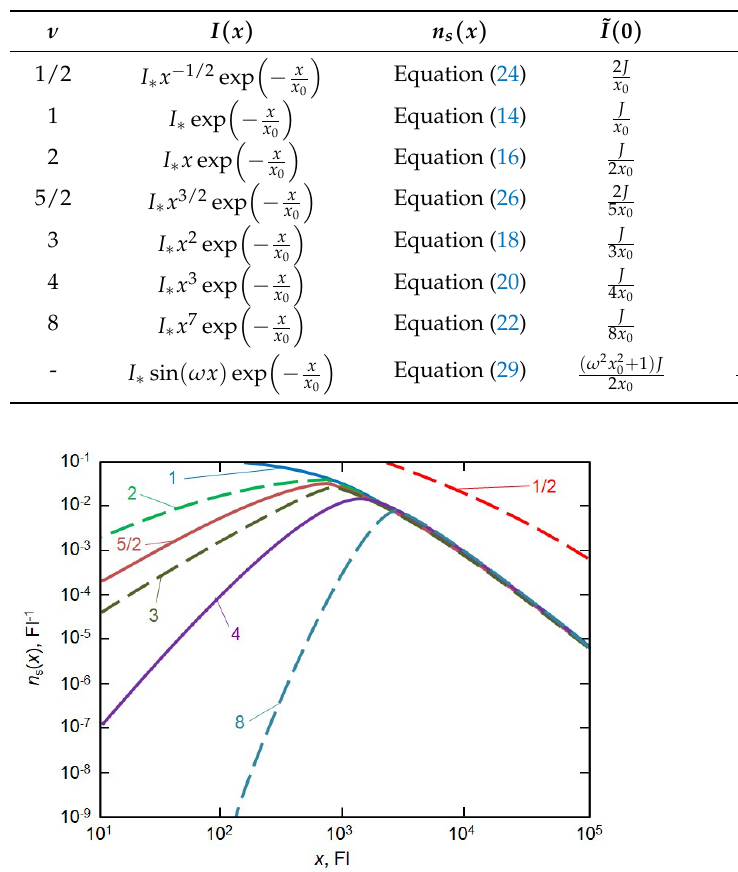
Table 1. A short summary of exact steady-state solutions.